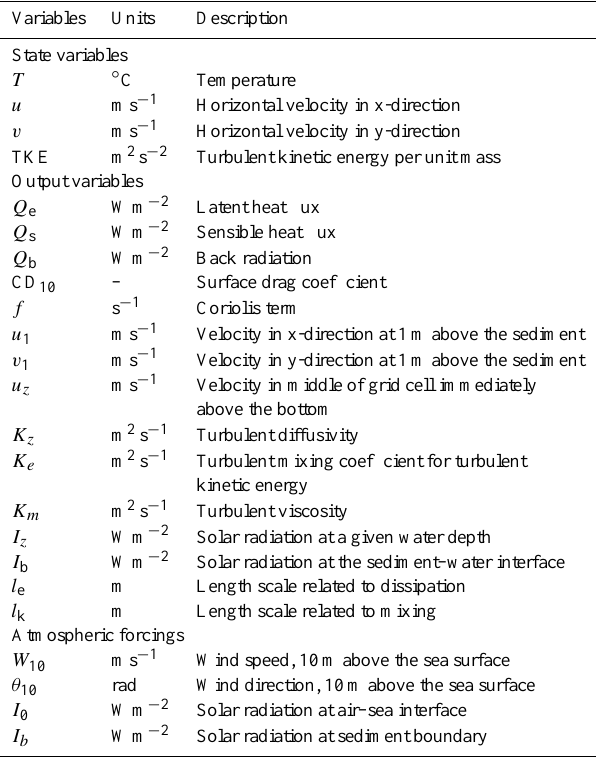
Table 2. State variables, output variables and forcing functions of the physical k - ε